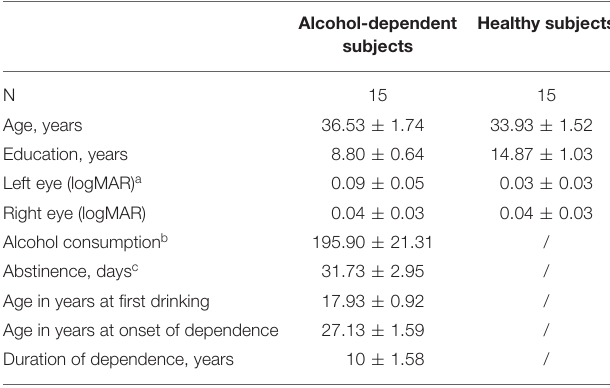
TABLE 1 | Demographic and alcohol-related data for patients and controls. Alcohol-dependent